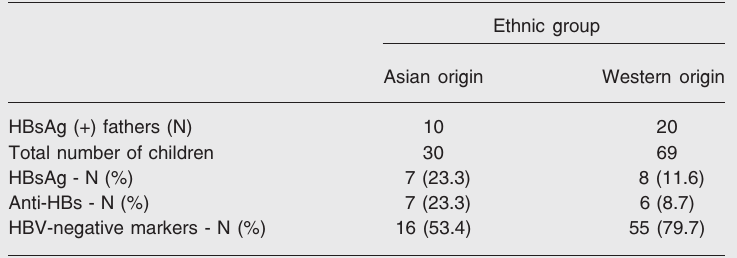
Table 4. Frequency of hepatitis B virus (HBV) markers in the progeny of HBsAg- positive fathers.